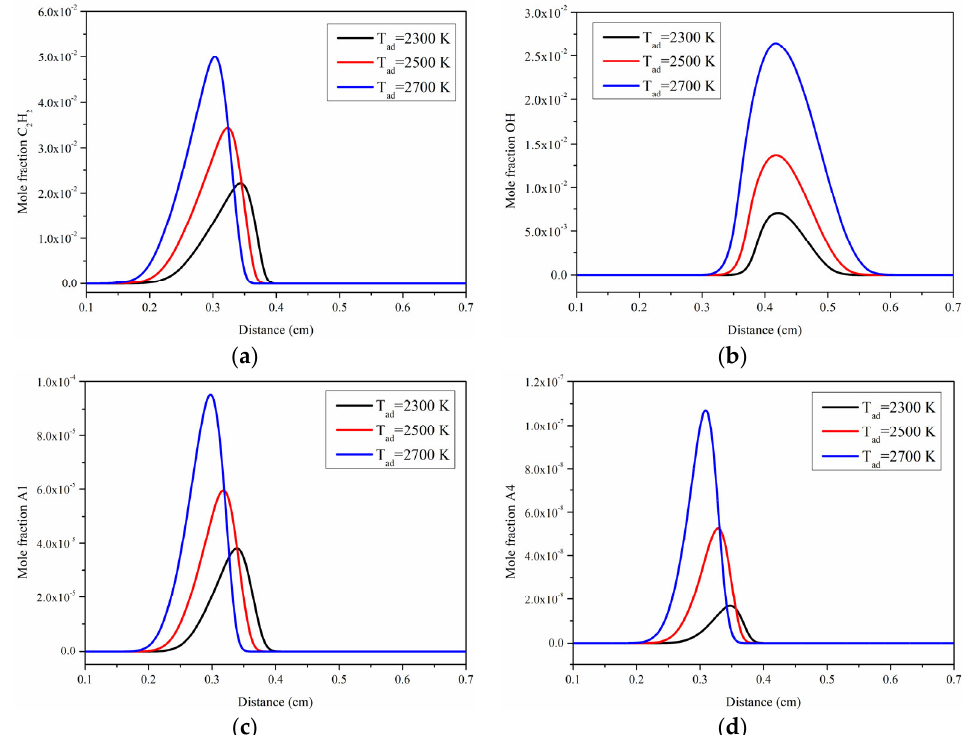
Figure 11. The mole fraction distributions of C 2 H 2 ( a ), OH ( b ), A1 ( c ), and A4 ( d ) in cases 1.3, 2.2, and 3.1.